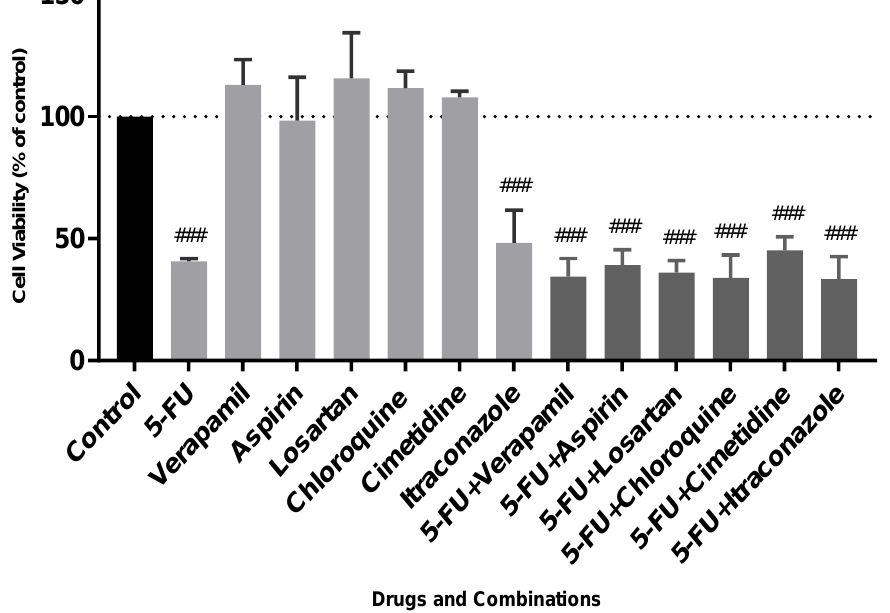
Figure 4. Cell viability values of single drugs and drug combinations in FMCm cells. All the compounds were added to cells in sextuplicates. The results (mean ± SEM) are presented as a percentage of the control (100%) of four independent experiments. ### p < 0.001 vs. control.